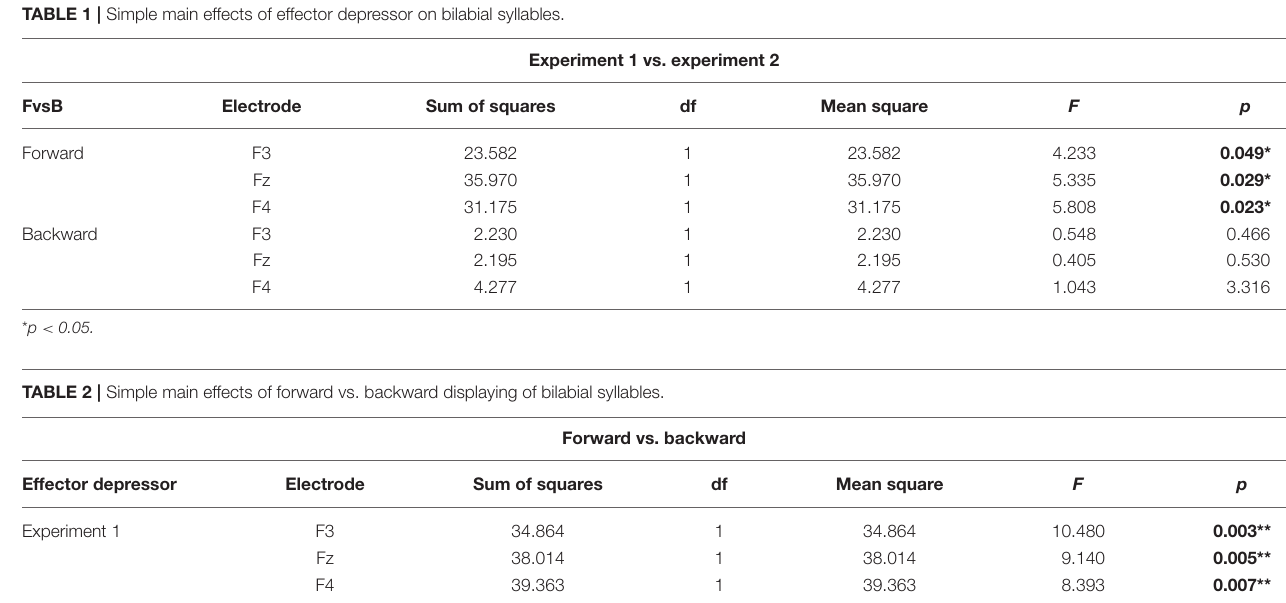
TABLE 1 | Simple main effects of effector depressor on bilabial syllables.